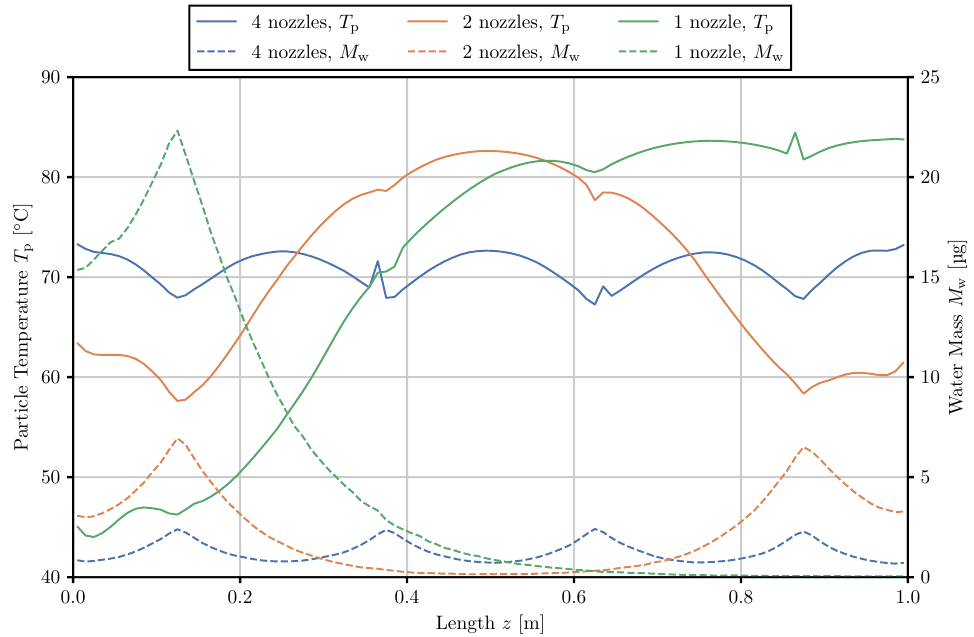
Figure 13. Distribution of particle surface liquid/water mass and particle temperature across the apparatus length for the same net amount of liquid ( ˙ M spray = 8 two and four